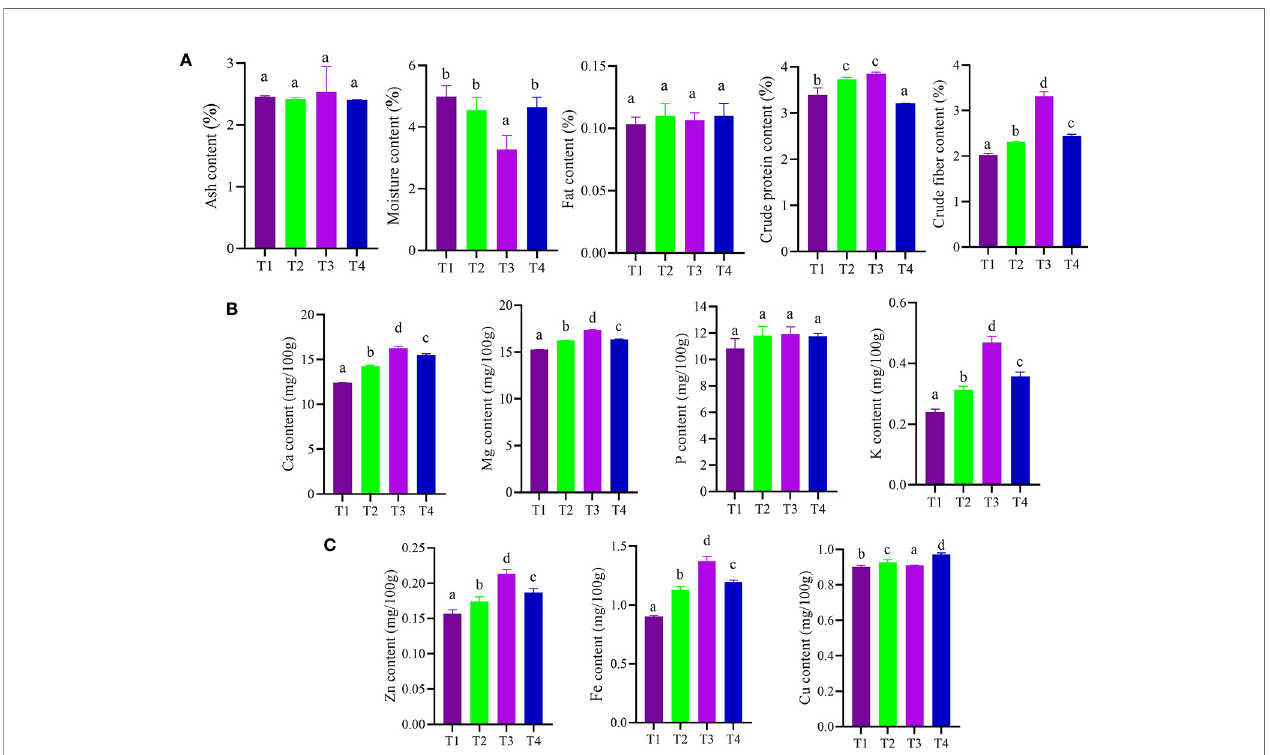
FIGURE 3 | (A) Effect of bacterial treatment on proximate constituents. (B) Effect of bacterial treatment on macronutrient contents. (C) Effect of bacterial treatment on micronutrient contents of C. annuum L. Where M: Moisture; CP: Crude protein; CF: Crude fi ber; A: Ash; F: Fat; K: Potassium; Ca: Calcium; Mg: Magnesium; P: Phosphorus; Zn: Zinc; Fe: Iron; Cu: Copper; T1: Untreated control; T2: seeds + CDK15; T3: seeds + CDK25; T4: seeds + Consortium (CDK15 + CDK25). Values are expressed as mean ± SD (n = 6), Level of signi fi cance: p < 0.05; Values with different superscripts are signi fi cantly different (One-way ANOVA followed by Duncan ’ s multiple range